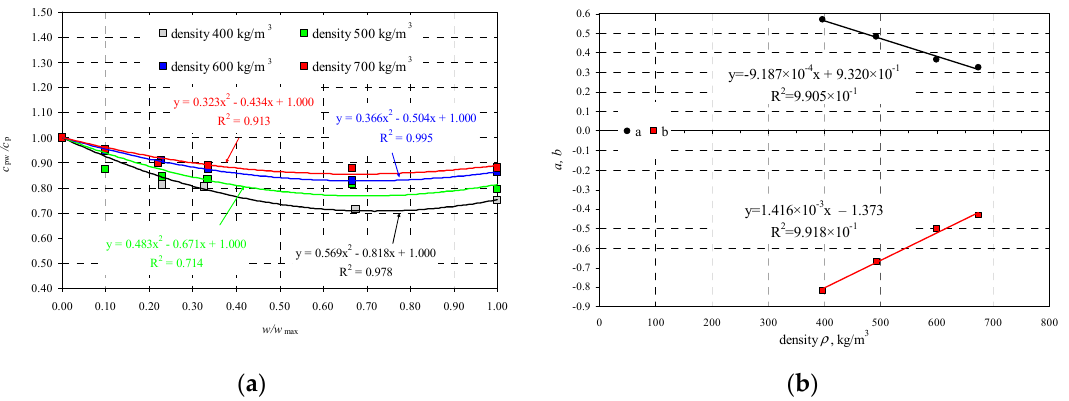
Figure 6. Relationship between velocity of ultrasonic wave propagation, moisture content and density: ( a ) relative changes in velocity of longitudinal wave as a function of relative moisture content w / w max , ( b ) values of coefficients as a function of AAC density.